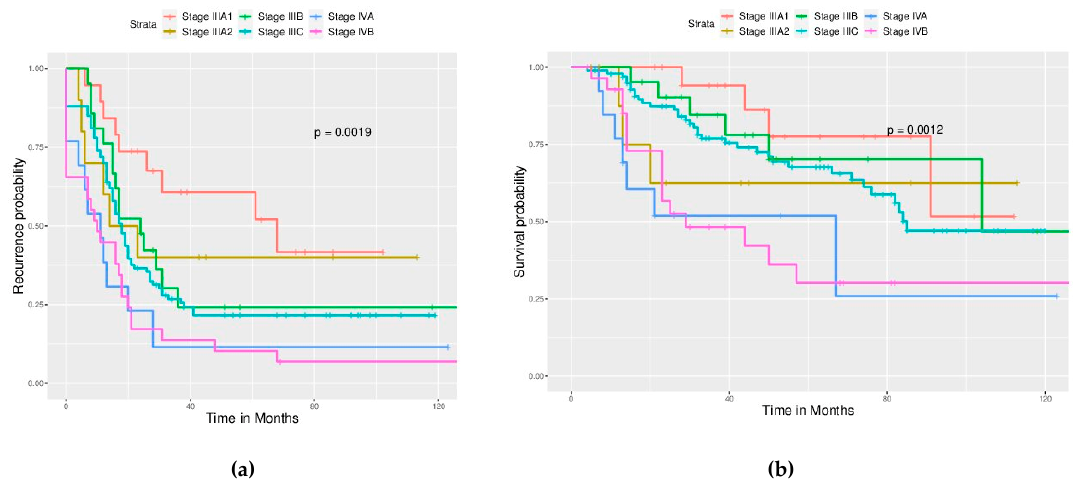
Figure 2. Survival curves based on the FIGO stage (All enrolled cases) ( a ) PFS, p = 0.0019. ( b ) OS, p = 0.0012. Stage IIIA1 has better PFS than other stages, and stage IV has worse OS than stage III.